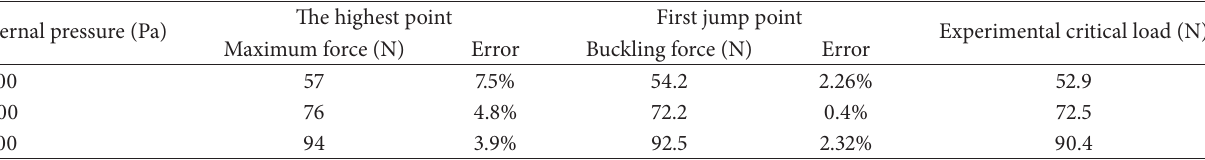
Table 6: Comparison of results between experiment and shell